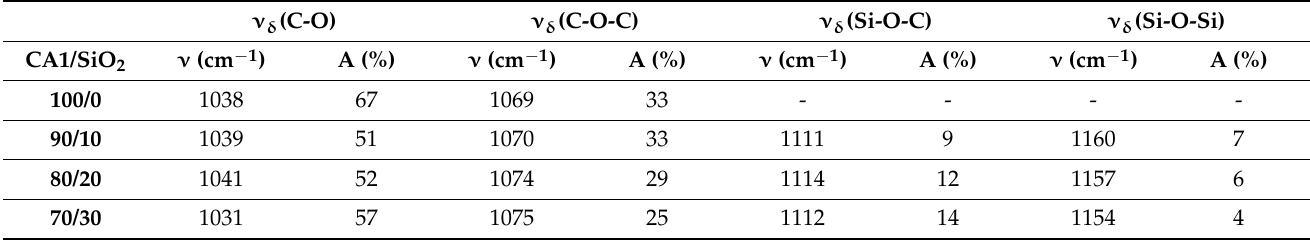
Table 2. Series one: frequency ( ν ) and relative area (A %) of the bands ν δ (C-O), ν δ (Si-O-Si), and ν δ